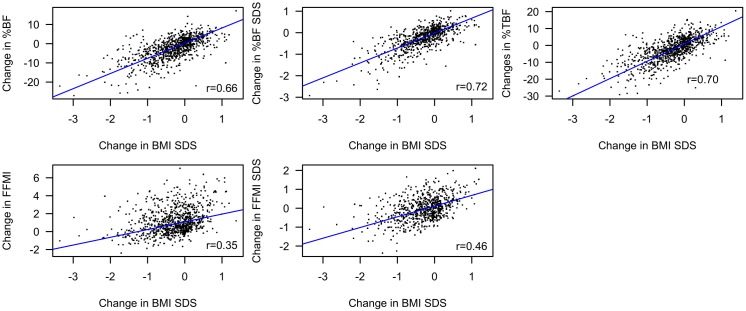
Associations between changes in BMI SDS and body composition variables.Plots showing the correlation between changes in BMI SDS and changes in %BF SDS, %BF, %TBF, FFMI SDS, and FFMI. BMI: body mass index. %BF: total body fat percentage. %TBF: truncal body fat percentage. FFMI: fat free mass index. SDS: standard deviation score.